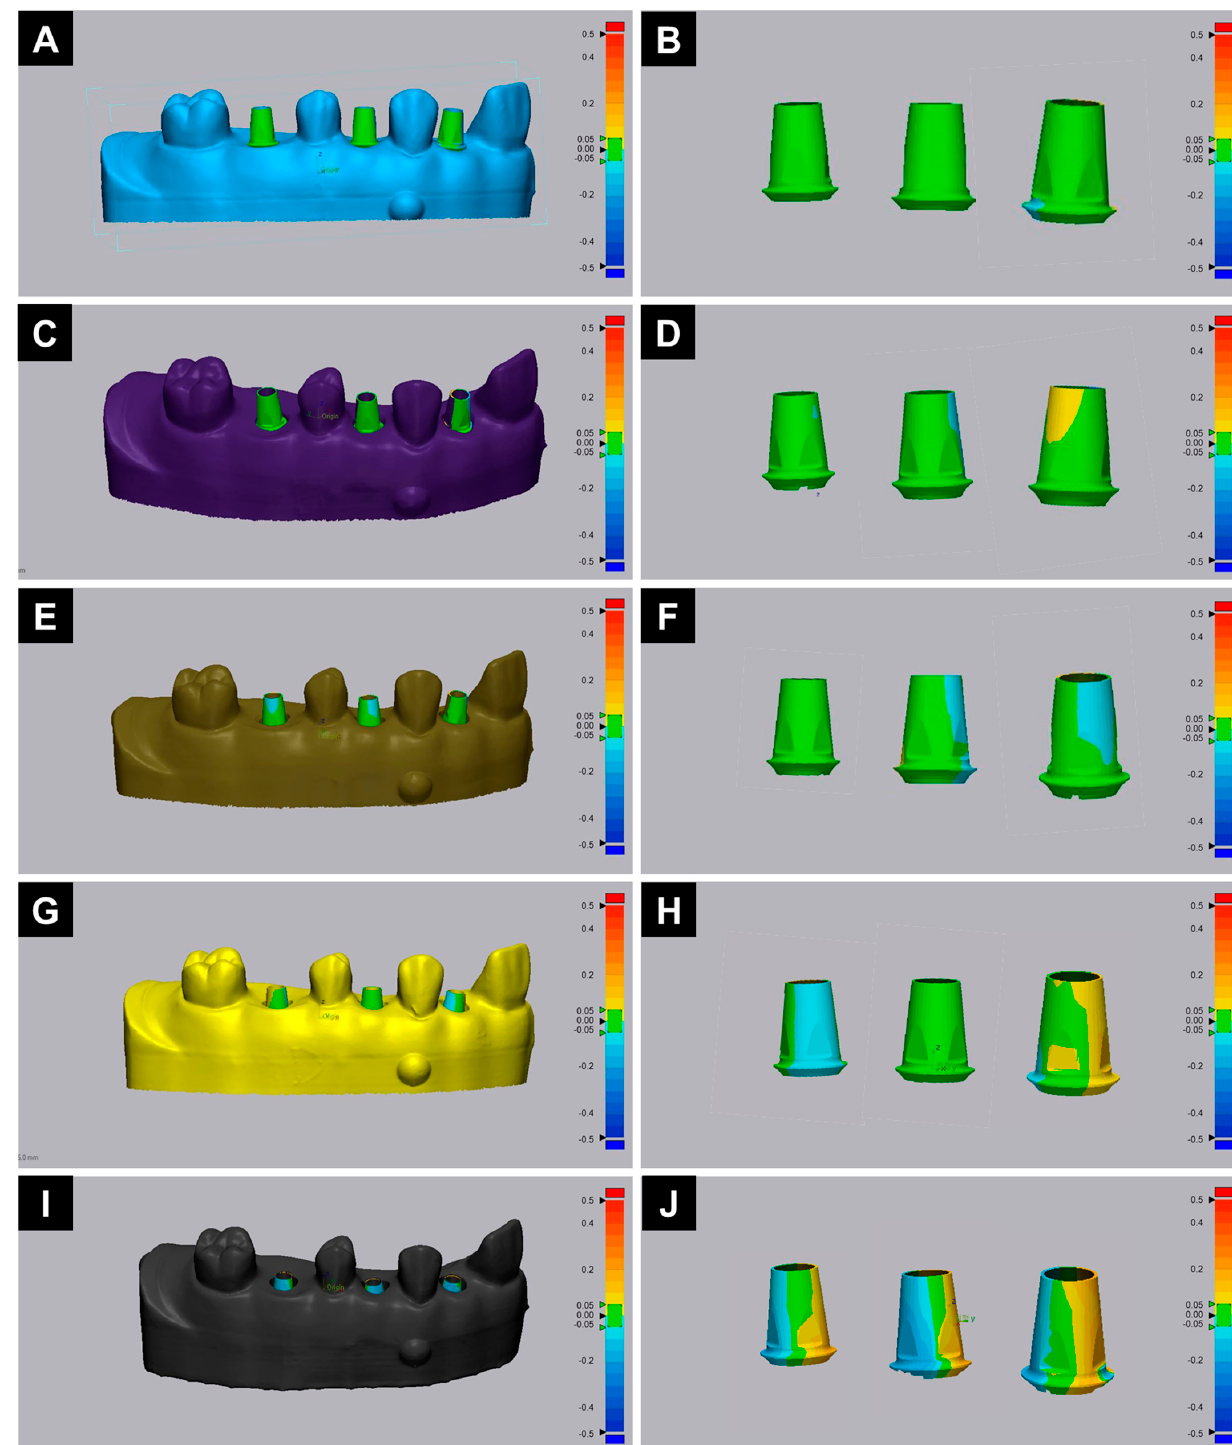
Figure 10. Results of 3D analyses of the abutment position after replacing the ISB with an implant abutment in five master models with different exposed lengths of the ISB: ( A , B ) normal bone level; ( C , D ) submerged 1.5 mm; ( E , F ) submerged 3.0 mm; ( G , H ) submerged 4.5 mm and ( I , J ) submerged 6.0 mm. As the implant placement depth increased there was a tendency for the error in the accuracy of reproducing the position of the analyzed abutment to increase.